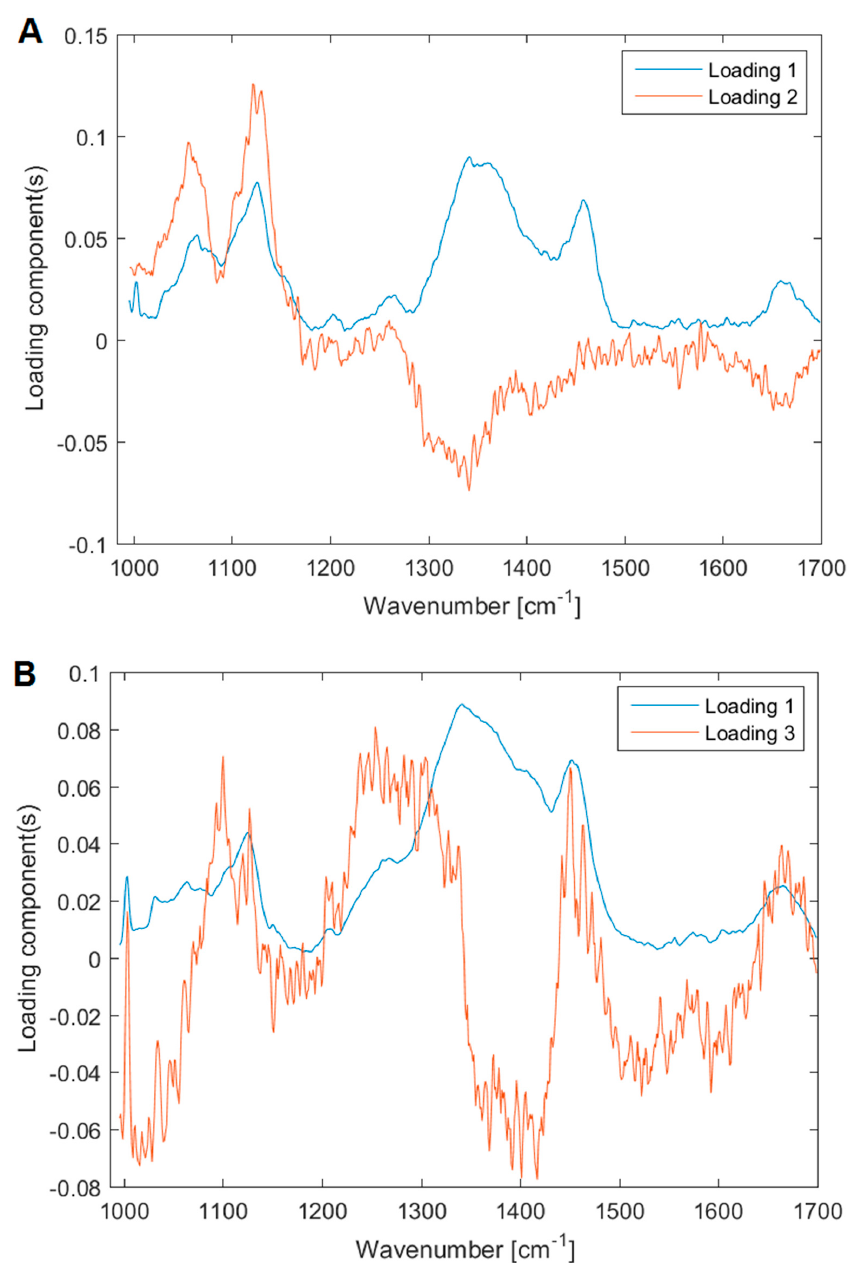
Figure 7. PCA loadings for the two species ( A ) Candida parapsilosis and ( B ) Staphylococcus epidermidis